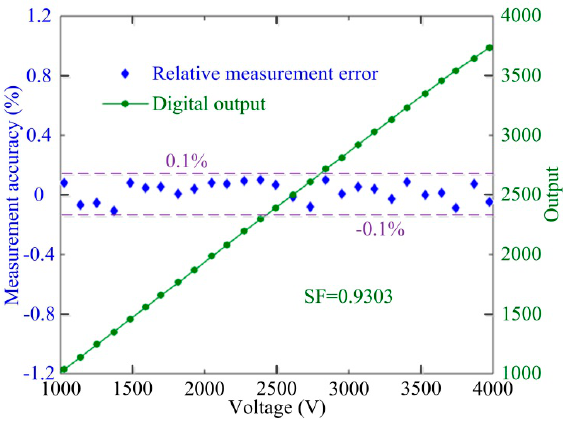
Figure 10. Relative measurement error, SF and digital output of OVS.